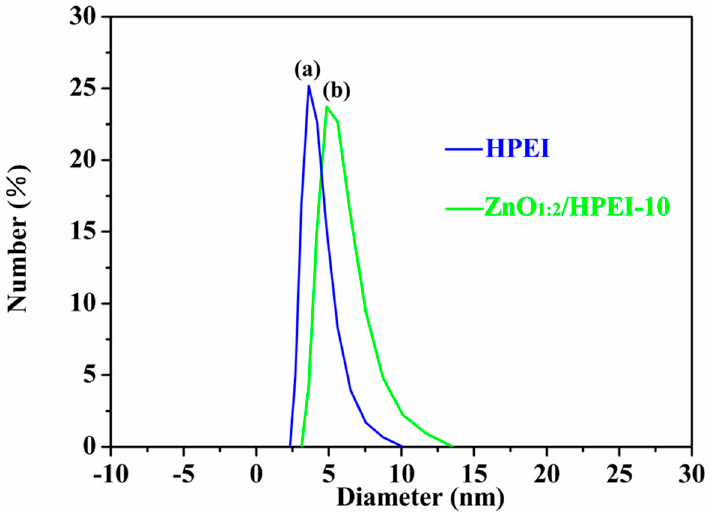
Figure 4. Size distribution of ( a ) neat HPEI and ( b ) ZnO 1:2 /HPEI-10 nanocomposites, measured by DLS.